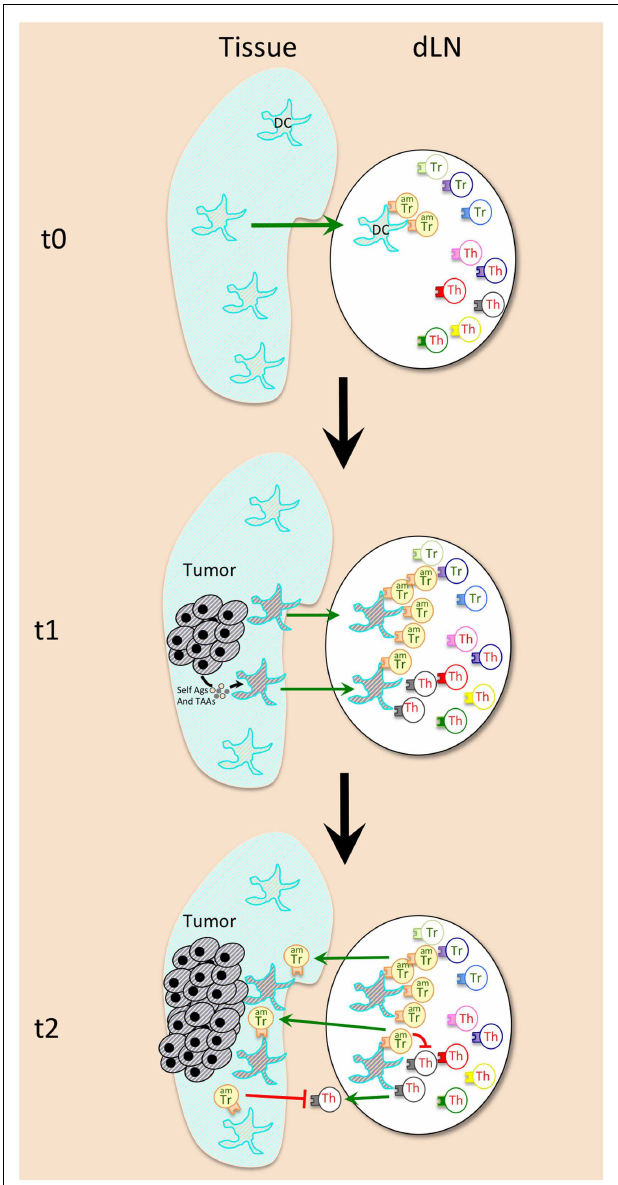
FIGURE 1 | Early events during cancer emergence lead to immune tolerance against tumor . Activated memoryTregs (AmTregs or amTr, beige lymphocytes) are the first to be stimulated by the presence of the tumor (gray round-shaped cells) via recognition of self-Ag presented by dendritic cells (DCs, star-shaped cells) coming from the tumor site (t1). AmTreg will then proliferate faster thanTAA-specificTeffs (Th, gray lymphocytes) that are naïve (or have already been suppressed at the steady state). AmTreg will then inhibit eitherTeff activation, proliferation, migration, and function either/or DCs presentation and costimulation